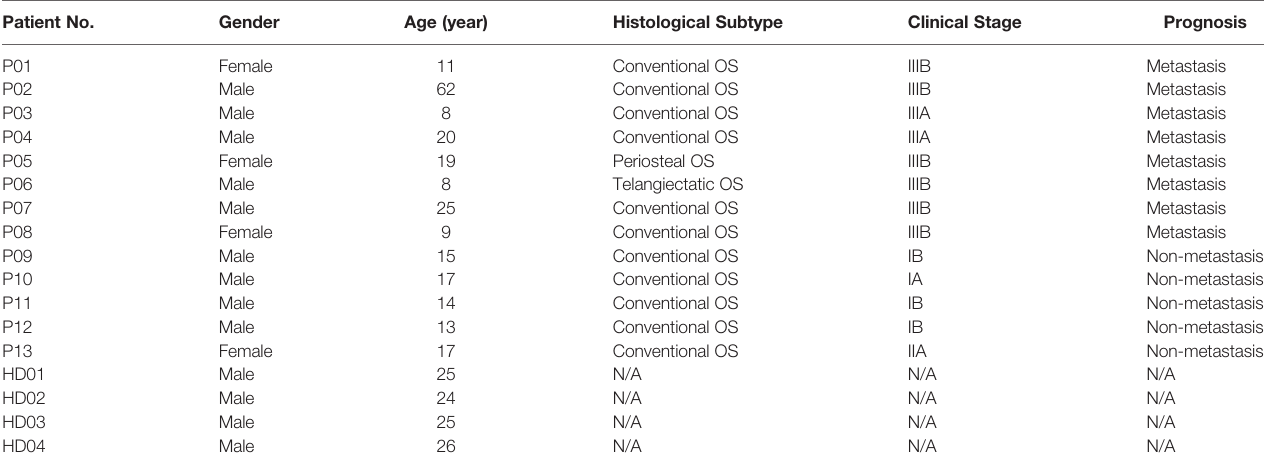
TABLE 1 | Clinical information of osteosarcoma (OS) patients and healthy donors (HD) enrolled in this study. Patient